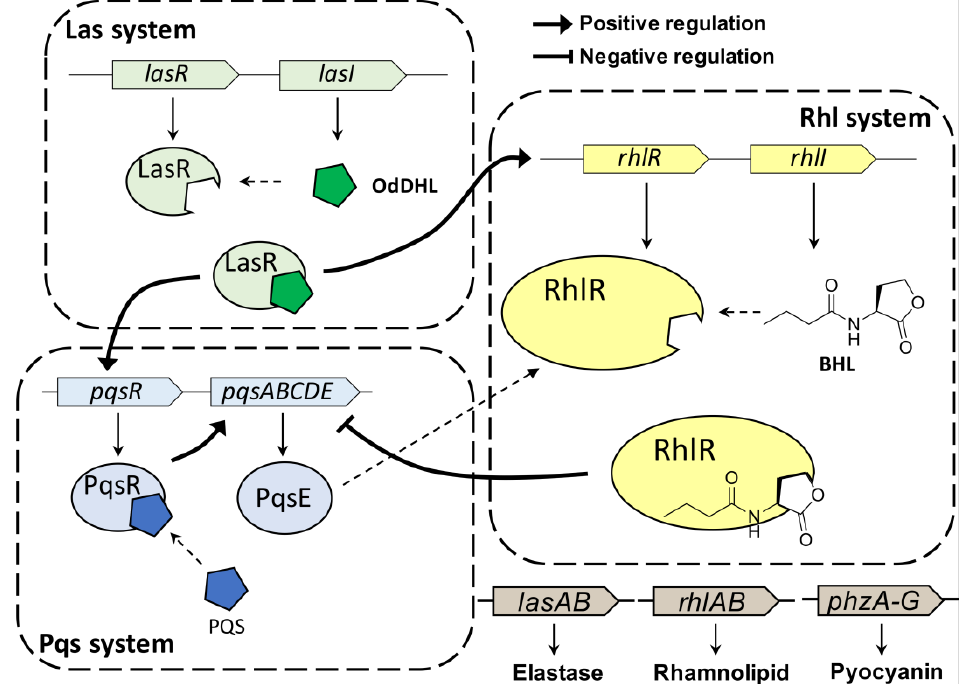
Figure 1. QS hierarchy in P . aeruginosa . RhlR is controlled in BHL-dependent or BHL-independent